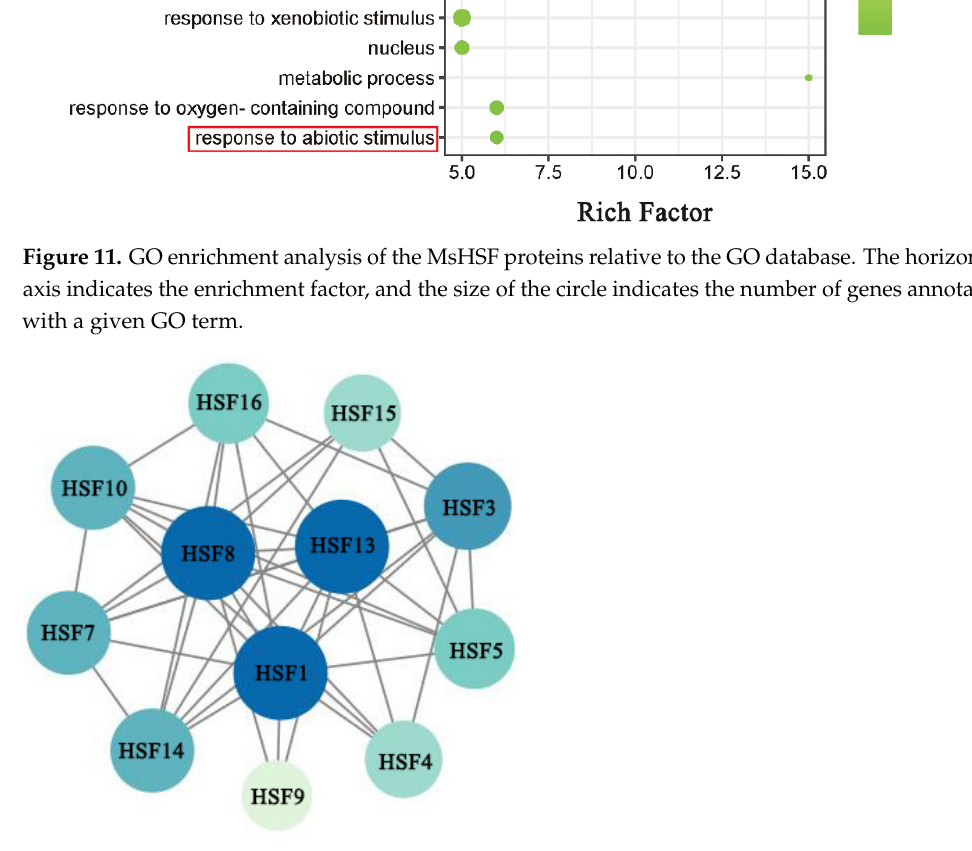
Figure 11. GO enrichment analysis of the MsHSF proteins relative to the GO database. The horizon- tal axis indicates the enrichment factor, and the size of the circle indicates the number of genes an- notated with a given GO term.